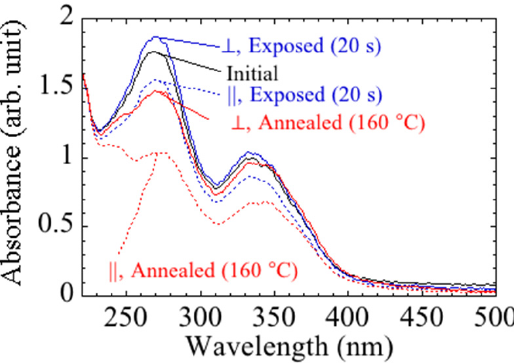
Figure 2. Polarized absorption spectra of P1 after spin-coating, irradiation with linearly polarized UV-laser, and annealing at 160 ◦ C for 10 min. The spectra are color-coded as black for initial, blue for irradiation, and red for annealing, respectively. The absorption spectra for the directions parallel and perpendicular to the polarization direction of the laser beam are indicated by solid and dashed lines,